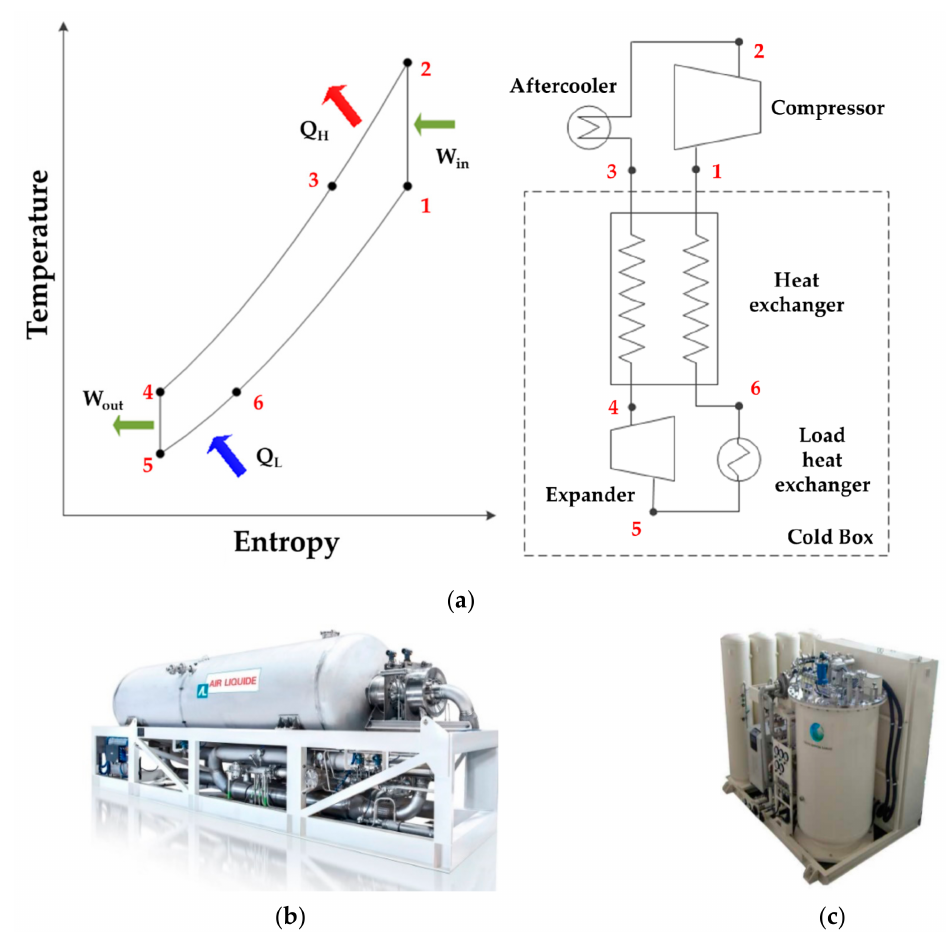
Figure 1. Reverse Brayton cryogenic system: ( a ) T-s and schematic diagram, ( b ) Air Liquide reverse Brayton cryogenic system, and ( c ) Taiyo Nippon Sanso Brayton cryogenic